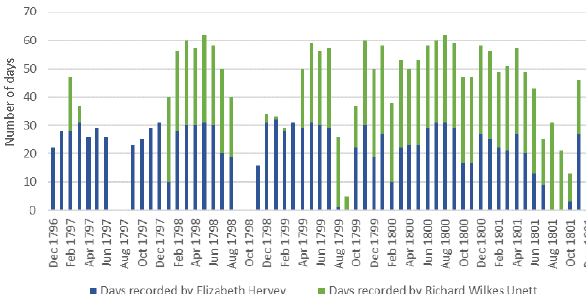
Figure 2. Number of days with weather recorded in London by the two diarists Elizabeth Hervey and Richard Wilkes Unett (Decem- ber